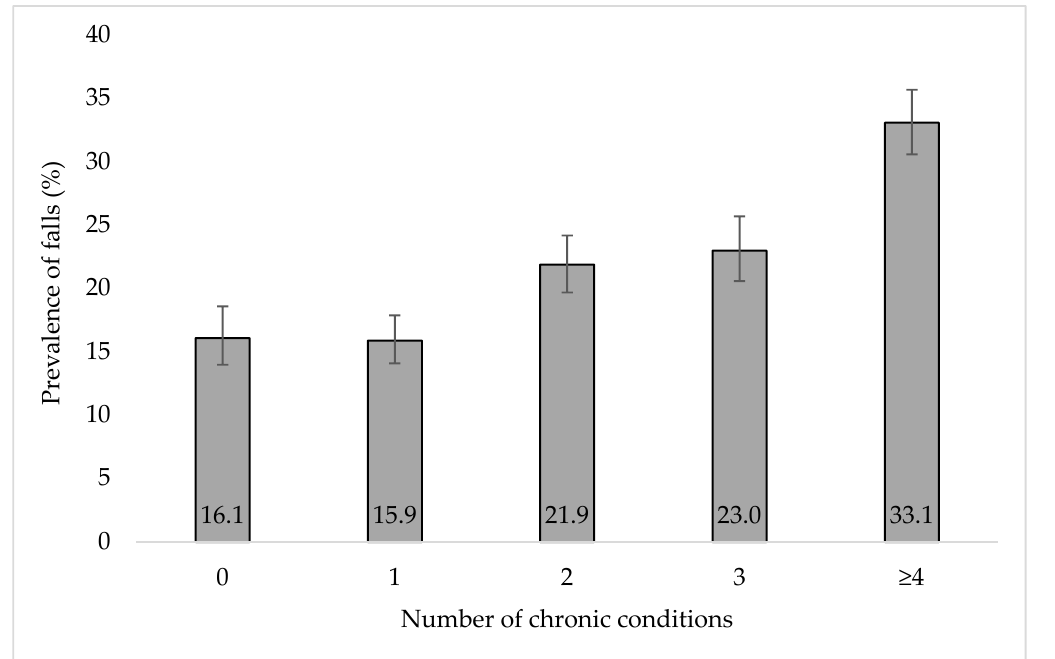
Figure 1. Prevalence of falls at follow-up by number of chronic conditions at baseline. Falls were those which were assessed at Wave 2 and referred to those that occurred since Wave 1. Bars denote 95% confidence intervals. p -value < 0.001 based on Chi-squared test.